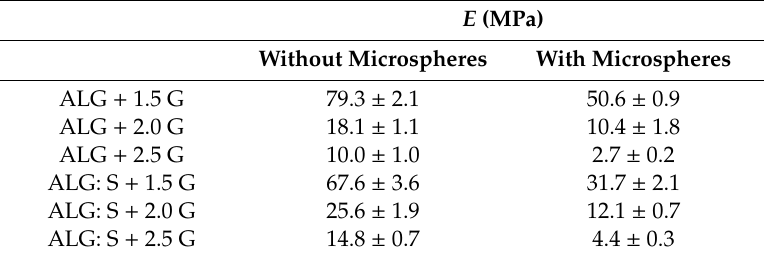
Table 2. The values of Young’s modulus ( E ) of sodium alginate-based films modified by the addition of microspheres and unmodified: ALG + 1.5 G, ALG + 2.0 G, ALG + 2.5 G—samples based on sodium alginate containing 1.5%, 2%, and 2.5% of glycerin, respectively. ALG: S + 1.5 G, ALG: S + 2.0 G, ALG: S + 2.5 G samples based on sodium alginate and starch containing 1.5%, 2%, and 2.5% of glycerin,